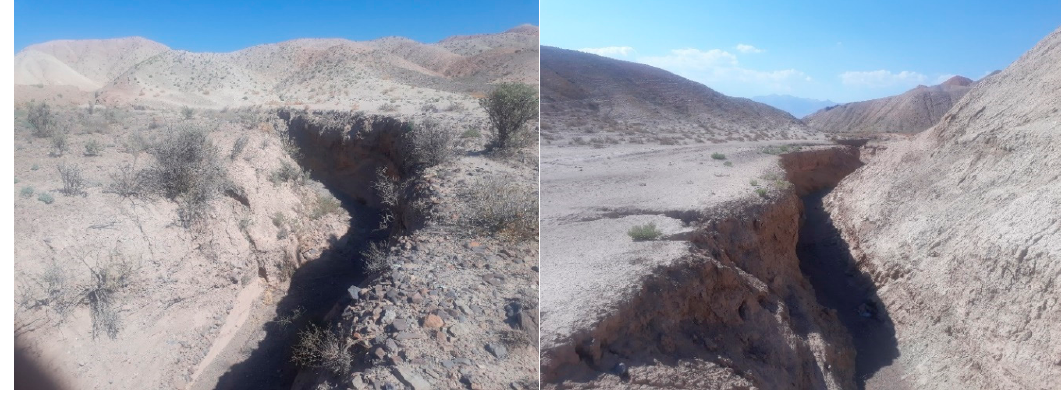
Figure 2. Sample of gullies in the study area.